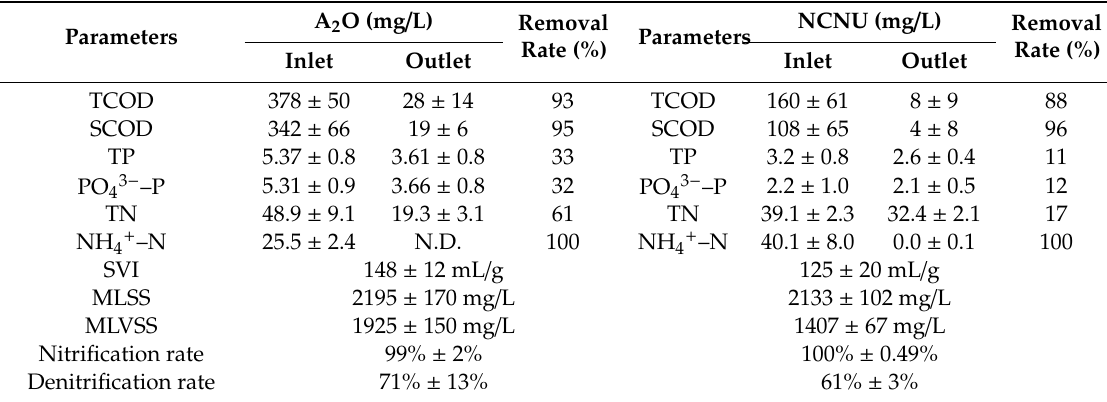
Table 4. Comparison of the concentration and removal rate of inflow and outflow of A 2 O operation and NCNU wastewater treatment